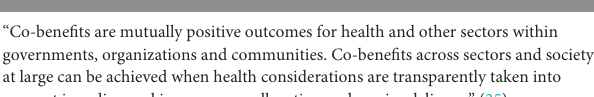
TABLE 2 Glossary of terms that are of relevance for the planetary health literacy model.